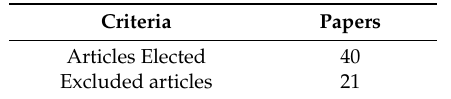
Table 4. Number of elected papers.